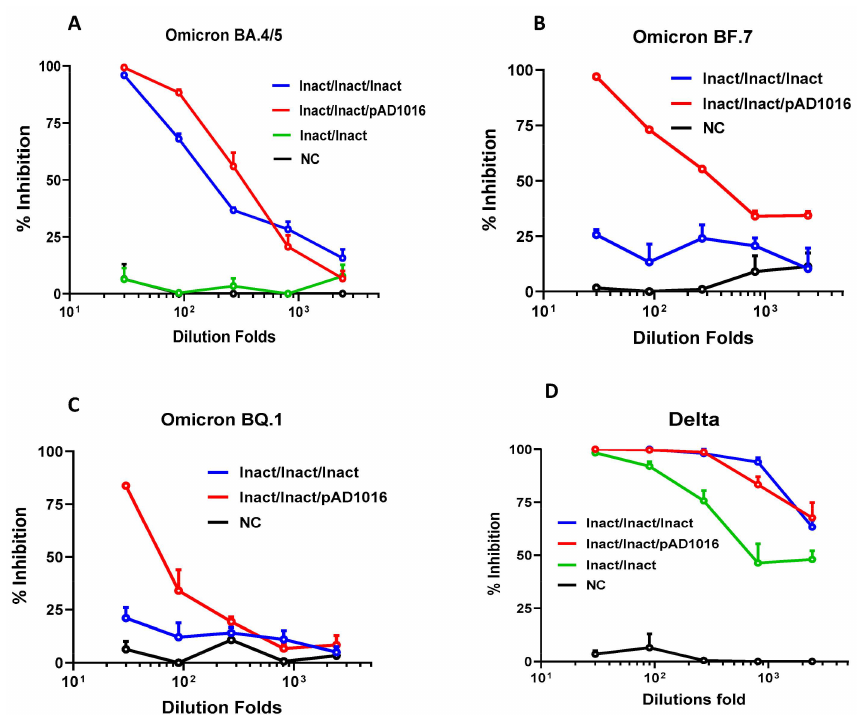
Figure 4. Effect of pAD1016 boost to inactivated virus pre-vaccination in mice. C57BL/6 mice ( n = 5) were i.m. administered with two doses of inactivated SARS-CoV-2 virus vaccine (60 units/dose), and then boosted with, or without (Inact/Inact), either inactivated SARS-CoV-2 virus vaccine (In- act/Inact/Inact) or 20 µ g pAD1016/IM+EP (Inact/Inact/pAD1016). Serum samples, collected 14 days after the secondary, or third, immunization were assayed for ability to block mimic infection of ACE2- expressing HEK293T cells by pseudoviruses displaying S protein of SARS-CoV-2 variants Omicron BA.4/5 ( A ), BF.7 ( B ), BQ.1 ( C ) or Delta ( D ). Normal mouse serum was included as negative control (NC). The results are expressed as percent inhibition of infection. Data are means ±